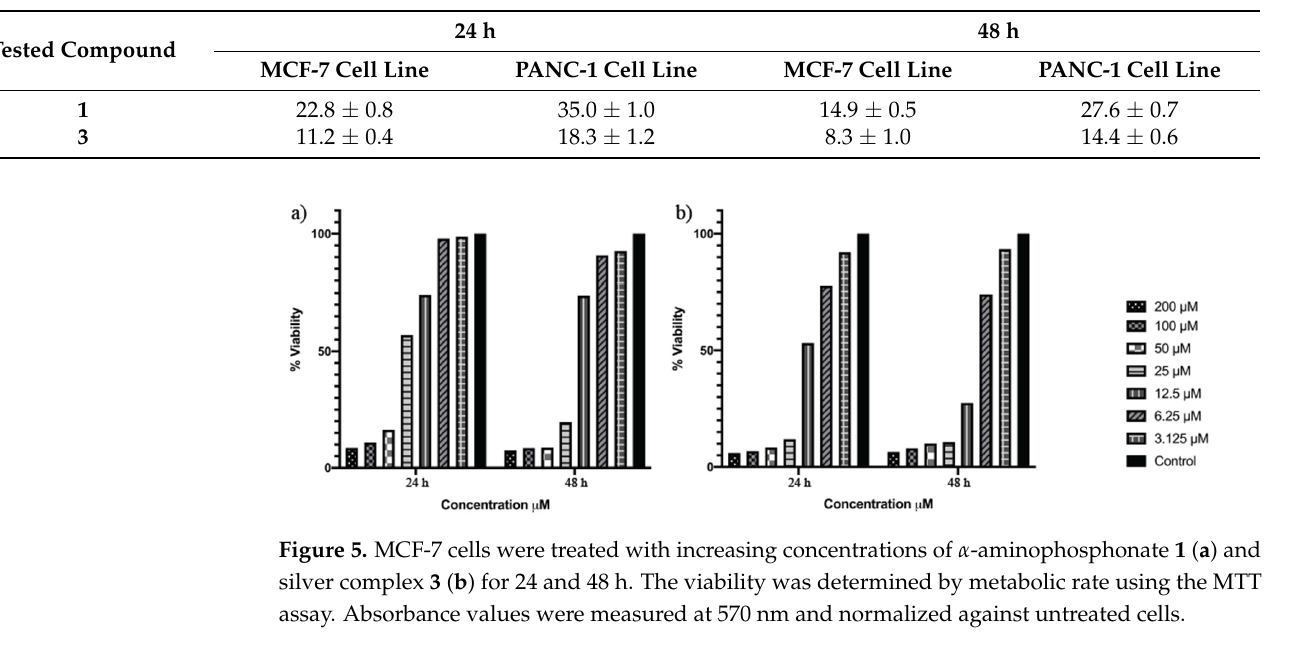
Table 2. Calculated IC 50 values ( μ M).